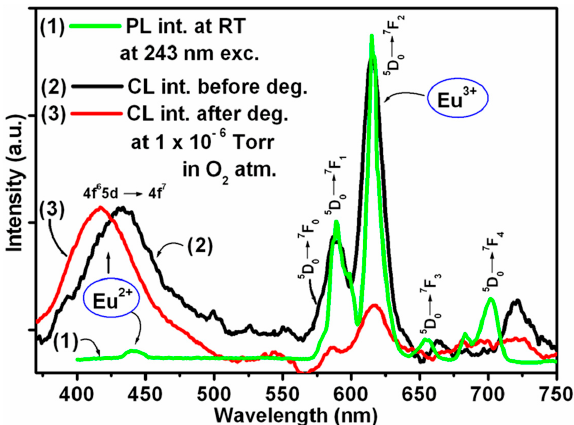
Figure 6. The comparative PL and CL output of the Sr 5 (PO 4 ) 3 F:Eu as function of Coulomb dose at 1 × 10 − 6 Torr O 2 atmosphere under electron beam excitation with the primary beam voltage and beam current of 2 keV and 10 µA, respectively [5].